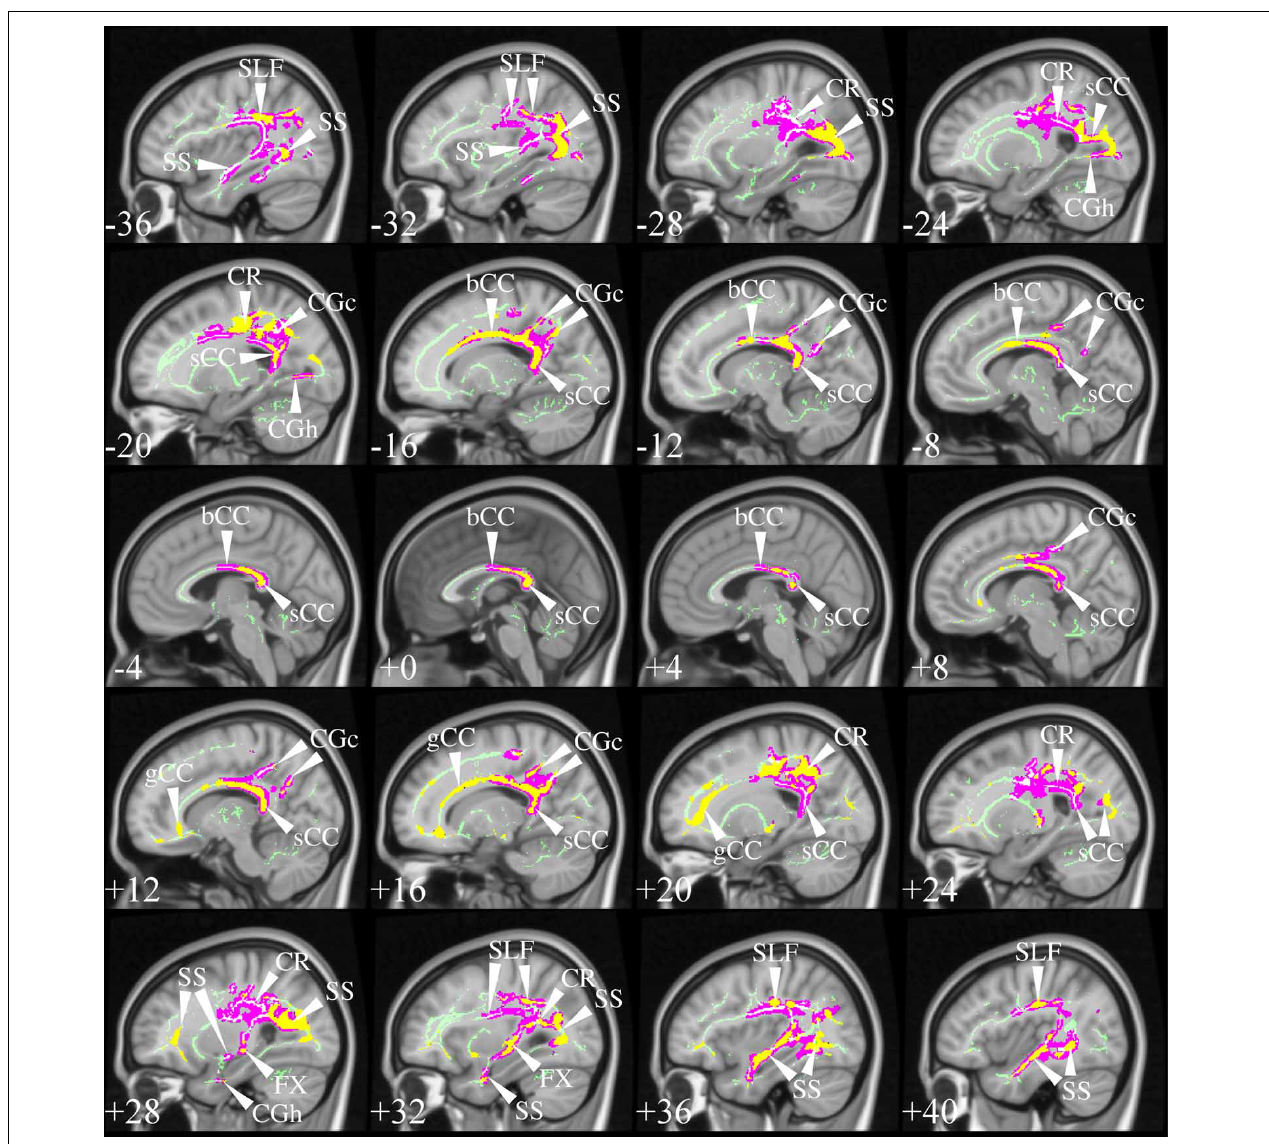
FIGURE 9 | TBSS in AD. TBSS results for N = 43 early-stage AD patients (age: 70 ± 6, < MMSE > = 24 ± 4) vs. N = 26 matched controls (age: 68 ± 6) (Acosta-Cabronero et al., 2012). Pink clusters denote increased MD in patients, whereas those in yellow represent FA reductions at P < 0 . 05 enabling threshold free cluster enhancement (TFCE) (Smith and Nichols, 2009) and controlling the family-wise error (FWE) rate.